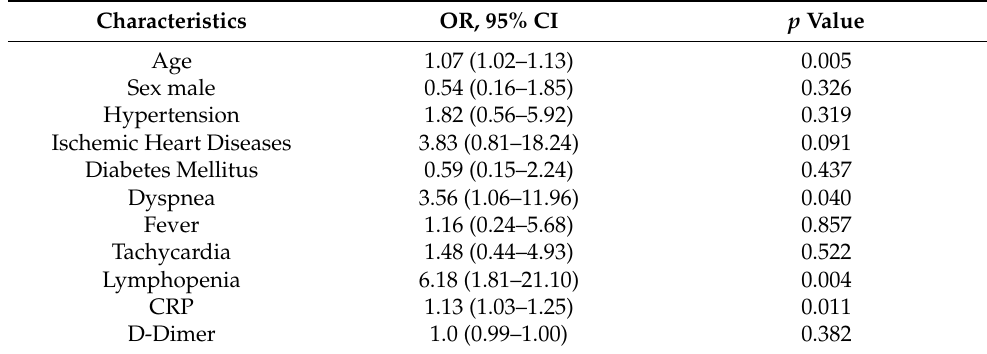
Table 3. Factors associated with oxygen requirement in admitted COVID-19-infected patients.